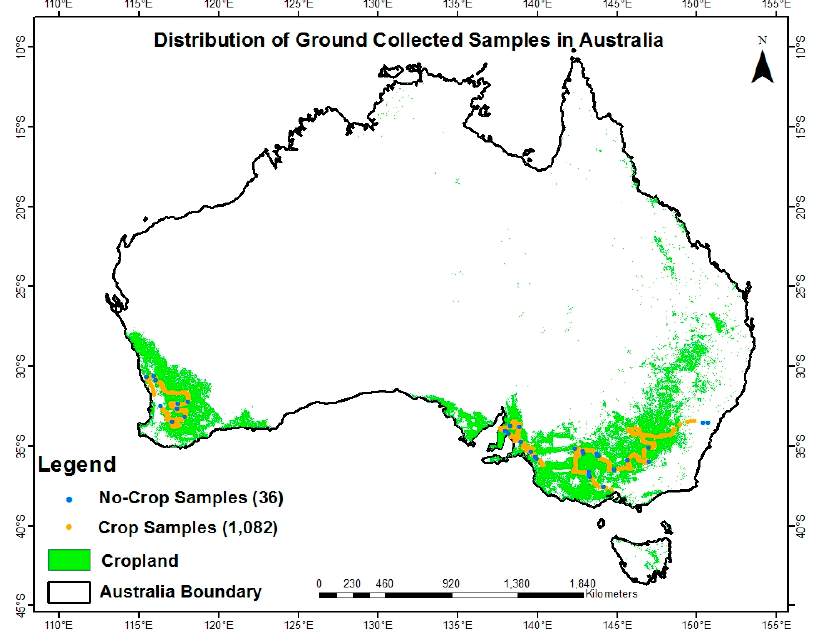
Figure 11. The distribution of ground collected samples used in the accuracy assessment of cropland map of Australia .